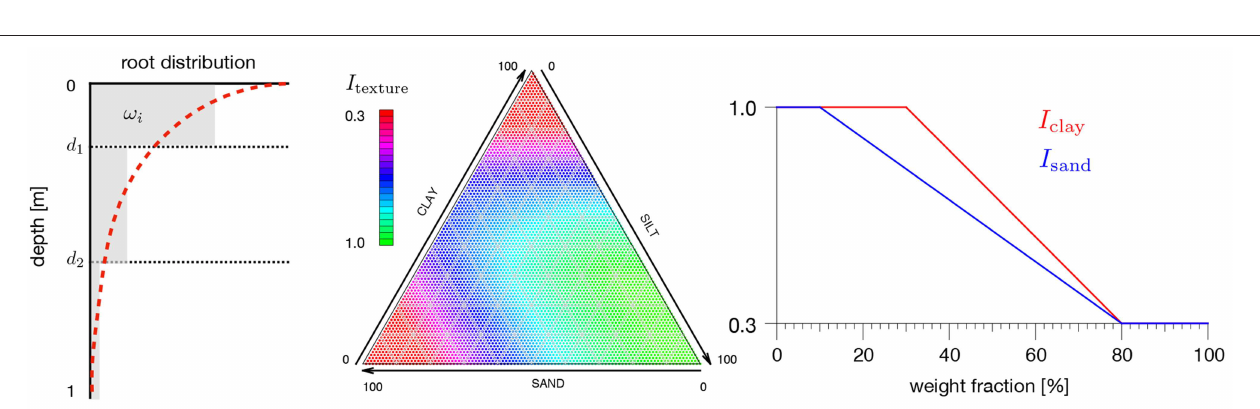
FIGURE 1 | (Left) Scoring function to get a dimensionless indicator for the water availability. (Right) Pedotransfer function to determine plant available water capacity, AWC , from soil texture to calculate the water deficit according to Equation 3. Maximum (28%) in green, minimum (10%) red.